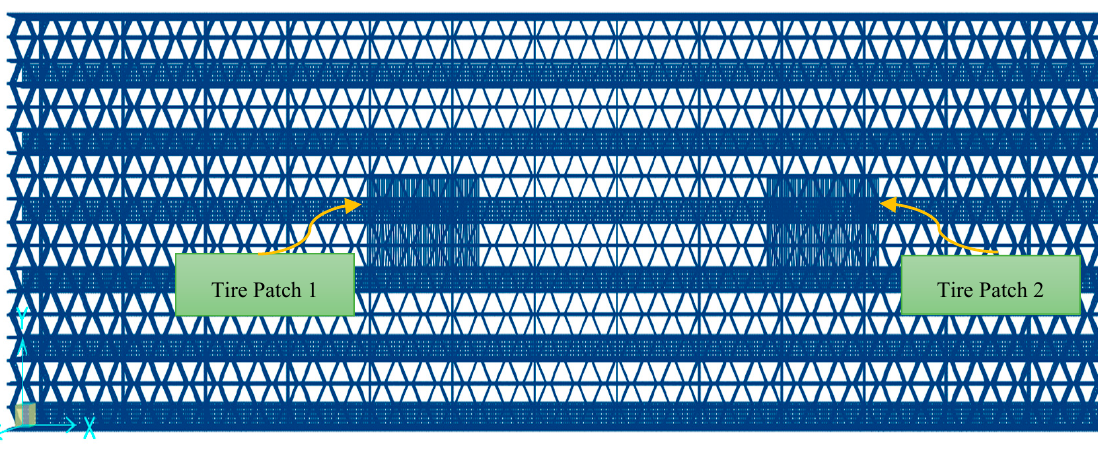
Figure 1. A 37R5 L-series L 127 mm × 76 mm × 6.35 (L 5 ″ × 3 ″ × 1/4 ″ ) panel.